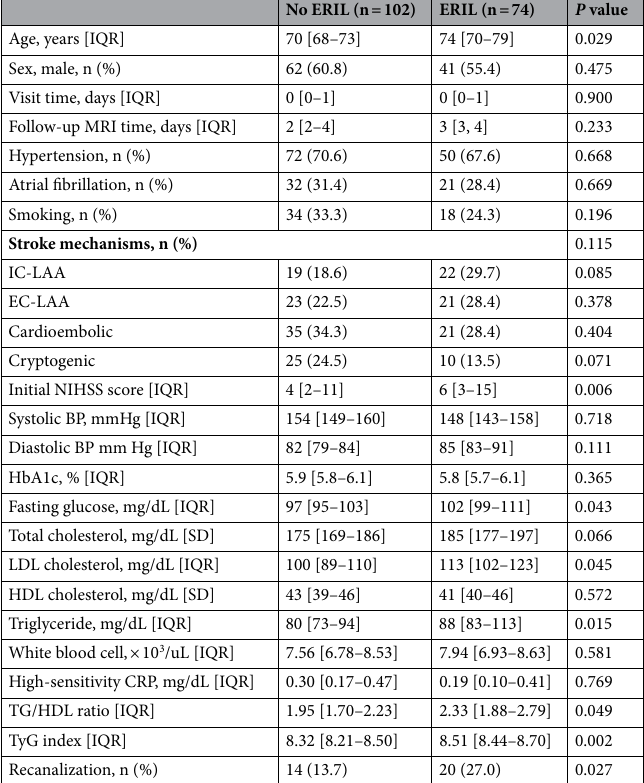
Table 1. Comparisons of baseline characteristics of patients with and without early recurrent ischemic lesion. ERIL early recurrent ischemic lesion, MRI magnetic resonance imaging, LAA large artery